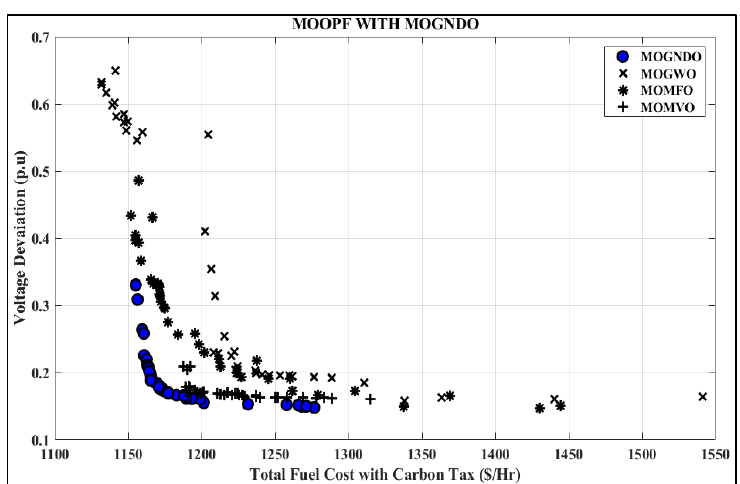
Figure 22. PF of TFC with a carbon tax and voltage deviation minimization.